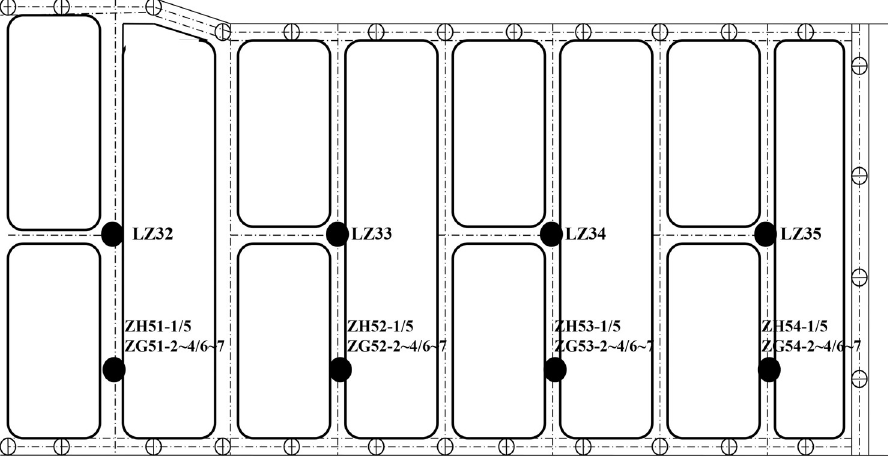
Fig 4. Axial force distribution of steel